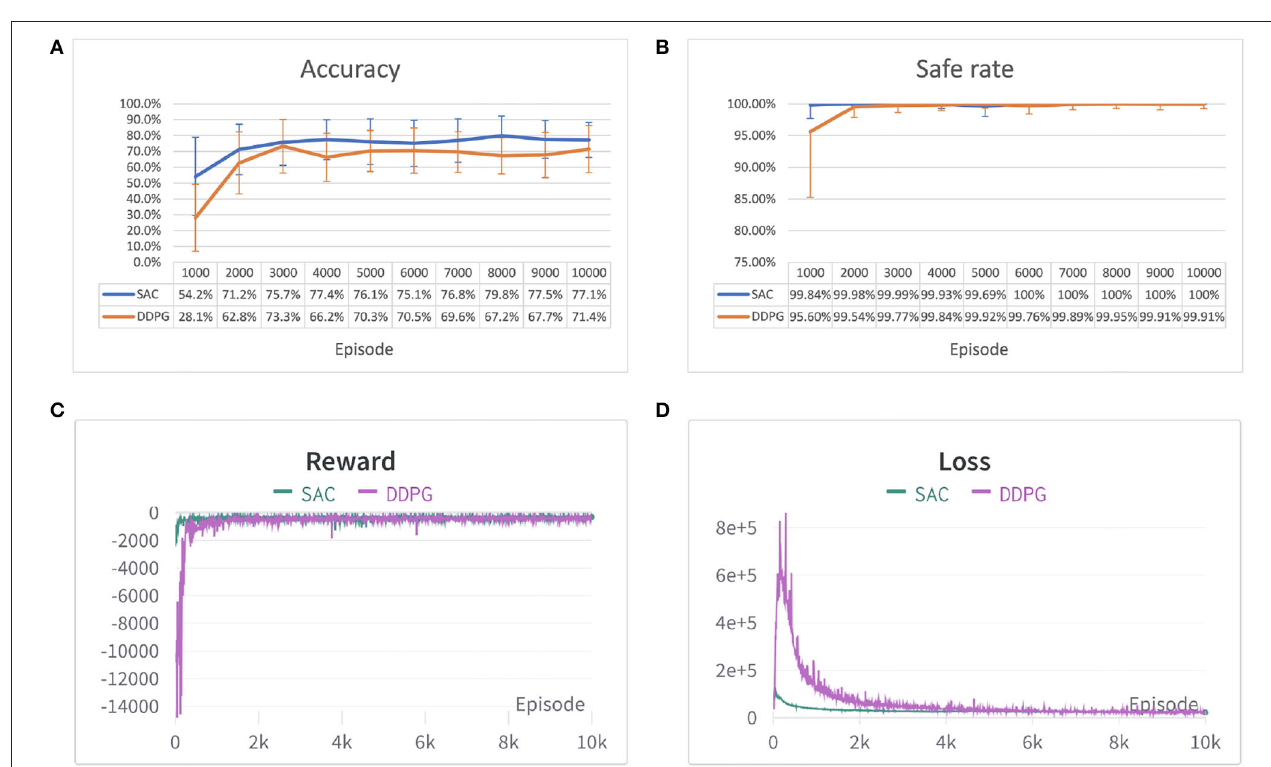
FIGURE 8 | Performance comparison of SAC and DDPG algorithm in the second environment. (A) Accuracy of different algorithms shown in error bar line graph. (B) A safe rate of different algorithms in the error bar line graph. (C) The cumulative reward for each episode. (D) Loss for each episode. Each episode corresponds to 100 time